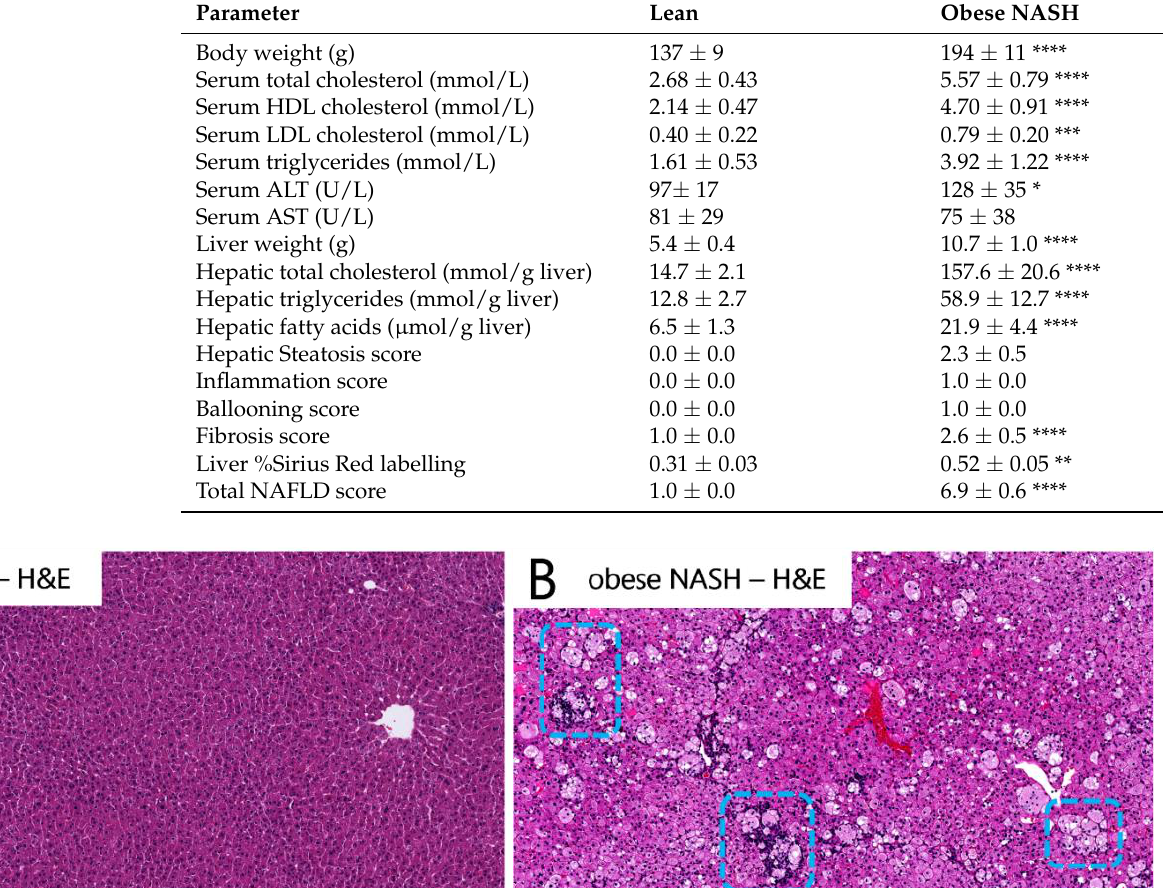
Table 2. Clinical and biochemical parameters in lean and obese NASH hamsters. Data are shown as mean ± SD, n = 10 hamsters per group. * p < 0.05, ** p < 0.01, *** p < 0.001, **** p < 0.0001 lean vs. obese NASH. Statistical analysis was performed using an unpaired 2-tailed Student t -test or a Mann–Whitney test.